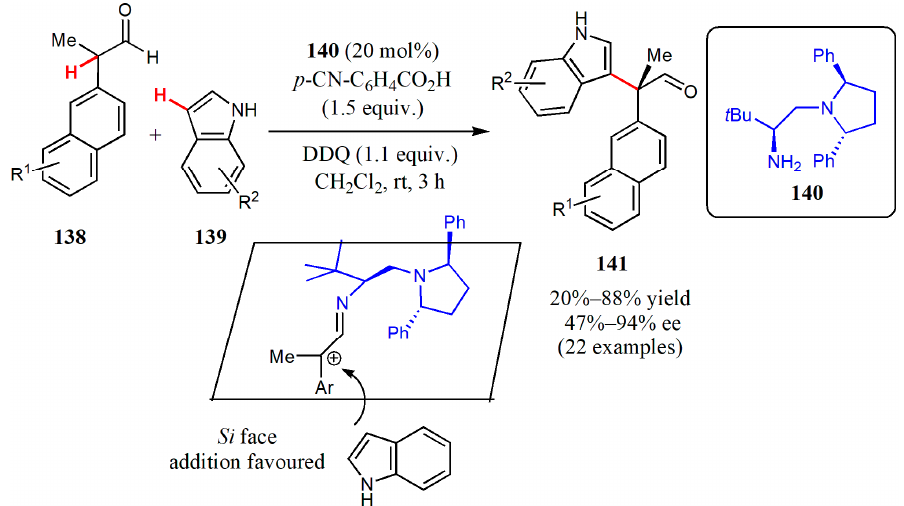
Figure 47. Enantioselective organocatalyzed CDC of indoles with aldehydes.